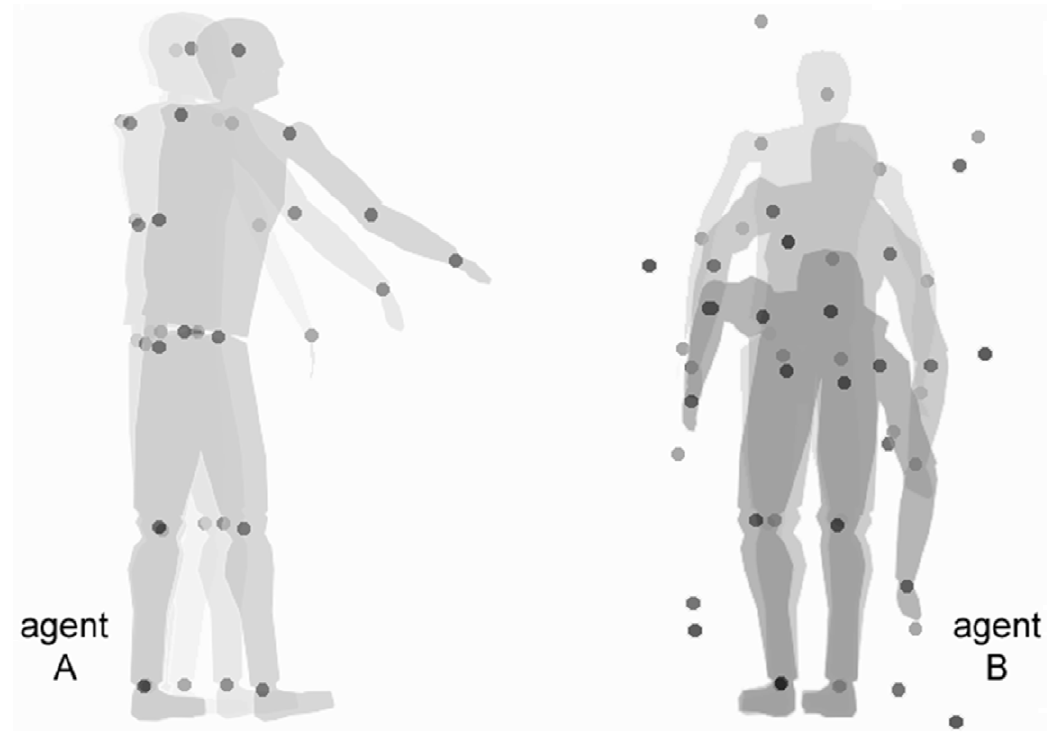
Figure 1. Example of a communicative signal trial. Agent A points to an object to be picked up; agent B bends down and picks it up. B was presented using limited-lifetime technique (6 signal dots) and masked with temporally scrambled noise dots. The noise level displayed is the minimum allowed in the experiment (5 noise dots). To provide a static depiction of the animated sequence, dots extracted from 3 different frames are superimposed and simultaneously represented; the silhouette depicting the human form was not visible in the stimulus display.